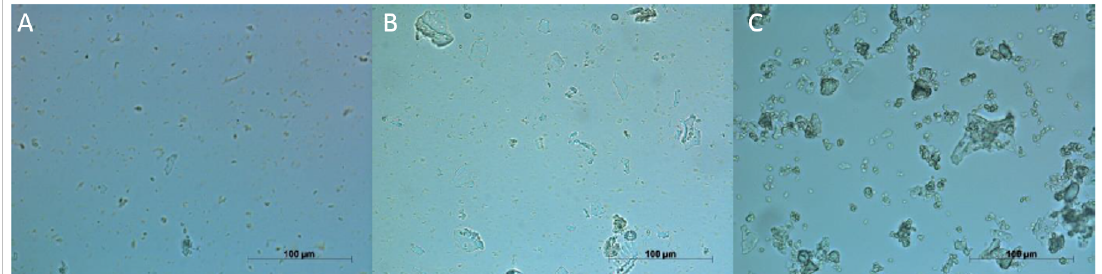
Figure 3. Light microscopy pictures of 0.02 gg − 1 dispersions of dry-heated and non-dry-heated FPC. Samples dry-heated at 150 ◦ C ( C ) showed larger particles than non-dry-heated FPC ( A ) and FPC dry-heated at 100 ◦ C ( B